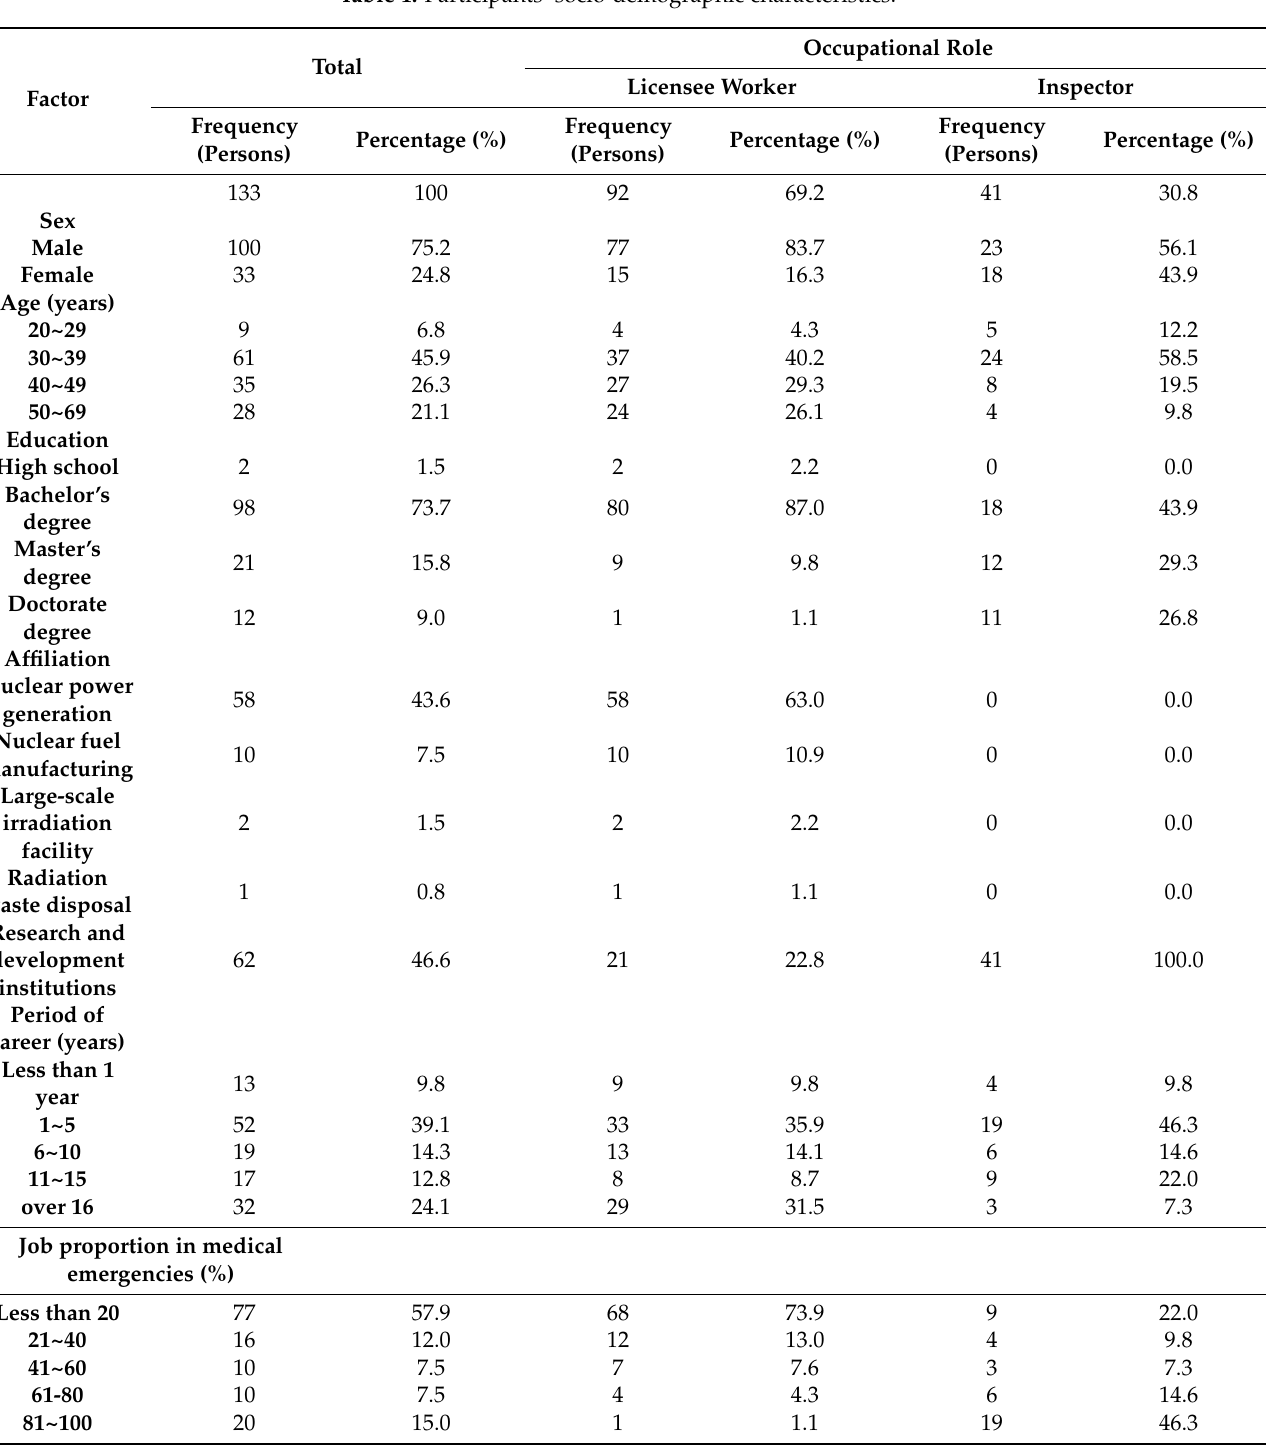
Table 1. Participants’ socio-demographic